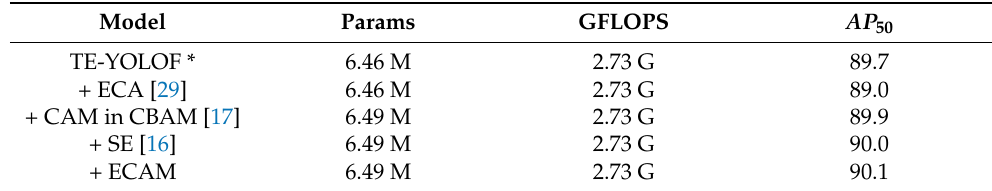
Table 2. Comparison with different Channel Attention Modules in TE-YOLOF without dilated encoder. The ‘*’ represents TE-YOLOF-B0 without dilated encoder and using 1 × 1 conv to reduce the channel number to default 512. Specifically, ‘+ ECA’ represents the Efficient Channel Attention used in